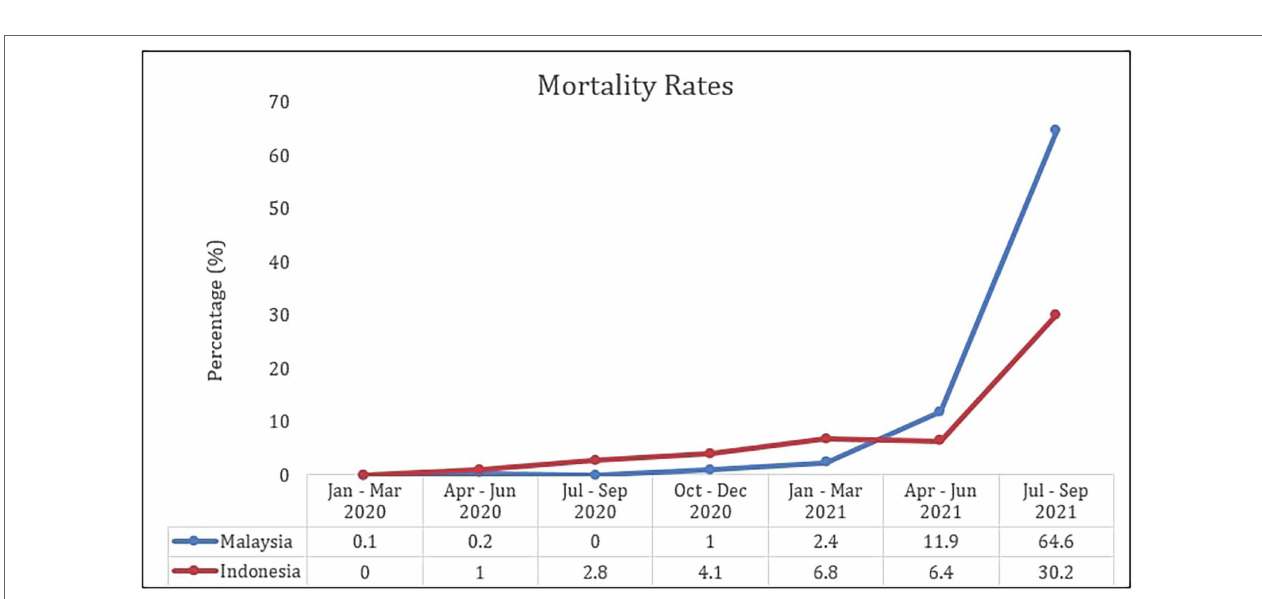
FIGURE 4 | Comparison of COVID-19 mortality rates in Malaysia and Indonesia (Rampal et al., 2021). **Mortality rates (per 100,000 population).